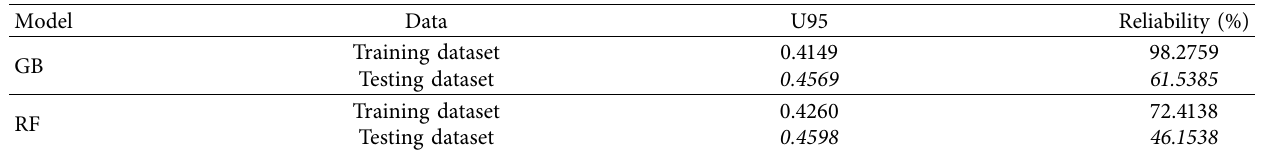
Table 6: U95 and reliability values of the GB and RF